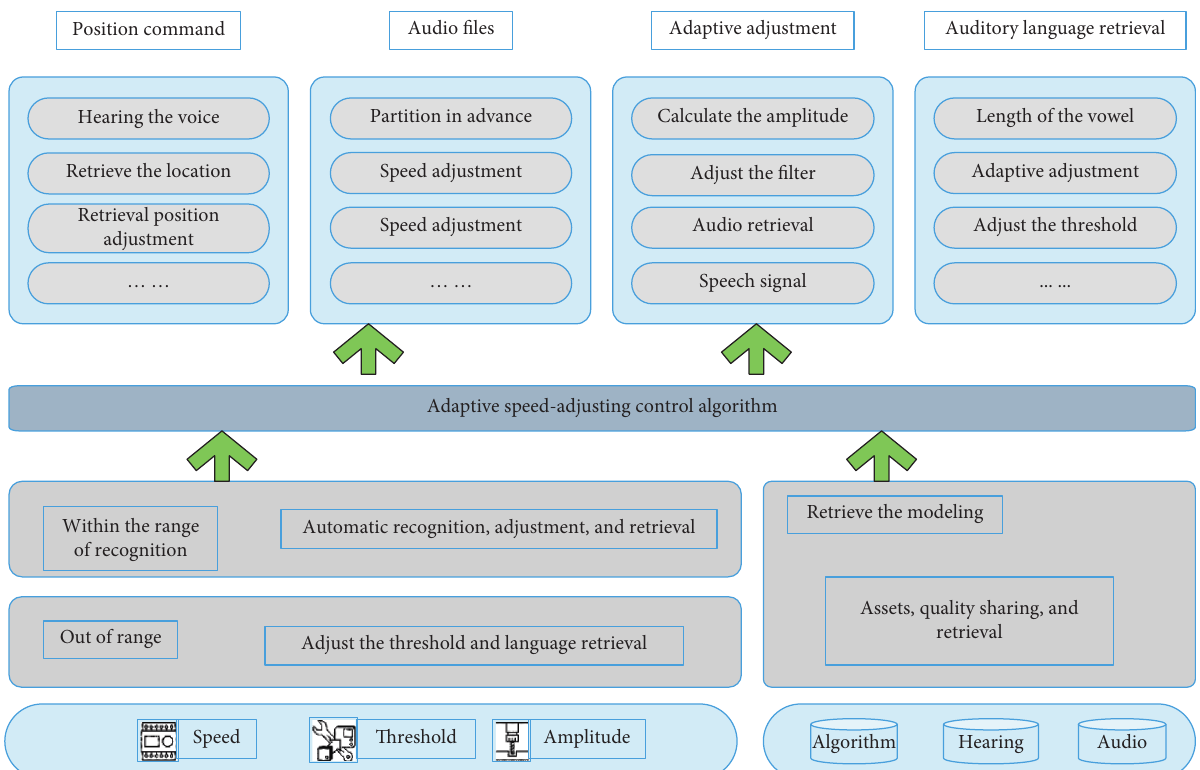
Figure 1: Block diagram of self-adaptive adjustment of speech